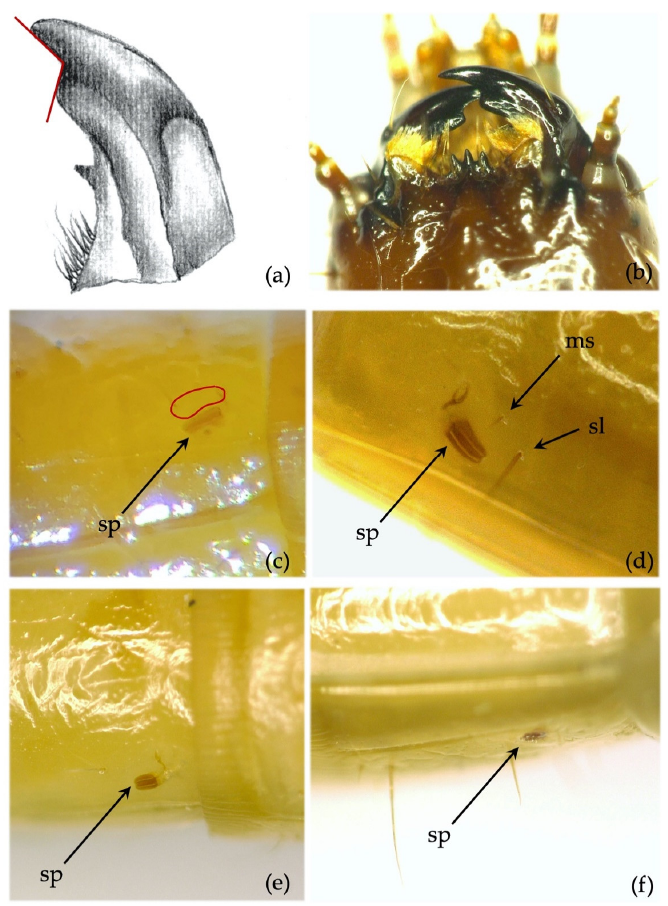
Figure 10. Agriotes obscurus (L. 1758) and Agriotes lineatus (L. 1767). Discriminating characters: ( a ) details of the right mandible of A. obscurus with subapical tooth forming an angle of approximately 90°; ( b ) mandibles of A. obscurus ; ( c ) lateral view of the abdominal segment of A. obscurus : red circle indicates the area where the minus setae is located; ( d ) dorso-lateral view of the abdominal segment of A. obscurus : ms, minus setae ; sl, large seta; sp, spiracle; ( e ) lateral view of the abdominal segment of A. lineatus ; ( f ) dorso-lateral view of the abdominal segment of A. lineatus : sp, spiracle.